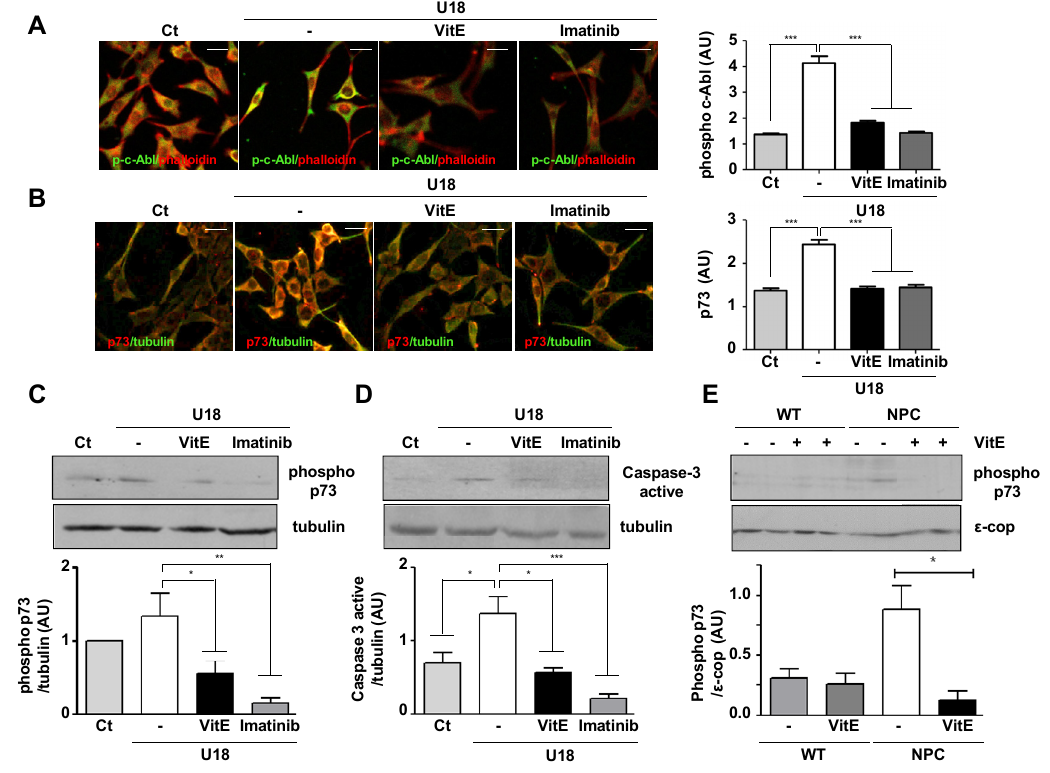
Figure 4. Vitamin E prevents U18666A induced cAbl/p73 and caspase 3 activation in HT22 neurons and p73 activation in the cerebellum of NPC mice. ( A , B ) Control (Ct) and U18-treated (0.5 μ g/mL for 24 h) HT22 cells in absence or presence of vitamin E (Vit E) (50 μ M) or Imatinib (5 μ M) were fixed and immunostained using anti-p-cAbl, anti-p73, Phalloidin:TRITC and anti- β -tubulin antibodies. Data shown are an average of three independent experiments, and graphs shown quantifications, in arbitrary units (AU) of both phosphorylated (phospho)-c-Abl and p73 levels; ( C , D ) Immunoblot analysis of phosphoporylated (phospho)-p73 and caspase 3 active. Lysates from control and U18-treated (0.5 μ g/mL for 24 h) HT22 cells in presence of vitamin E (Vit E) (50 μ M) or Imatinib (5 μ M) were resolved by 10% SDS-PAGE and analyzed by Western blot with anti-p-p73 and anti-caspase 3 active antibodies. Graphs show quantifications of phosphorylated (phospho)-p73 and caspase 3 active levels normalized by β -tubulin expression (arbitrary units, AU); ( E ) Immunoblot analysis of phospho p73 in NPC cerebellum. Cerebella homogenates from control- and Vit E-treated WT and NPC mice were analyzed at 7 weeks of age. The graph shows the quantification of p73 normalized by ε -cop expression (arbitrary units, AU). * p < 0.05, ** p < 0.01, *** p < 0.0001. Representative images of some experimental conditions are